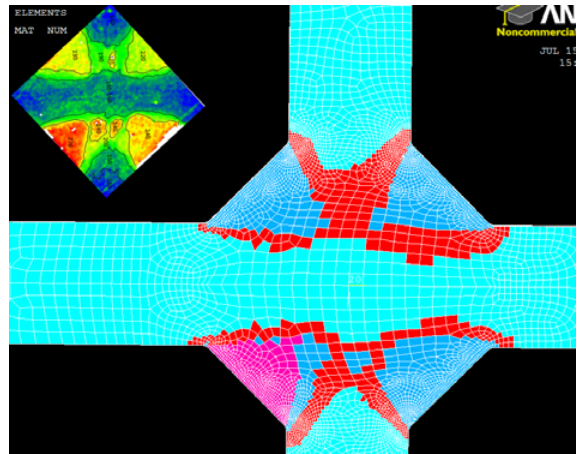
Figure 12: Different material zones defined in the FE model.